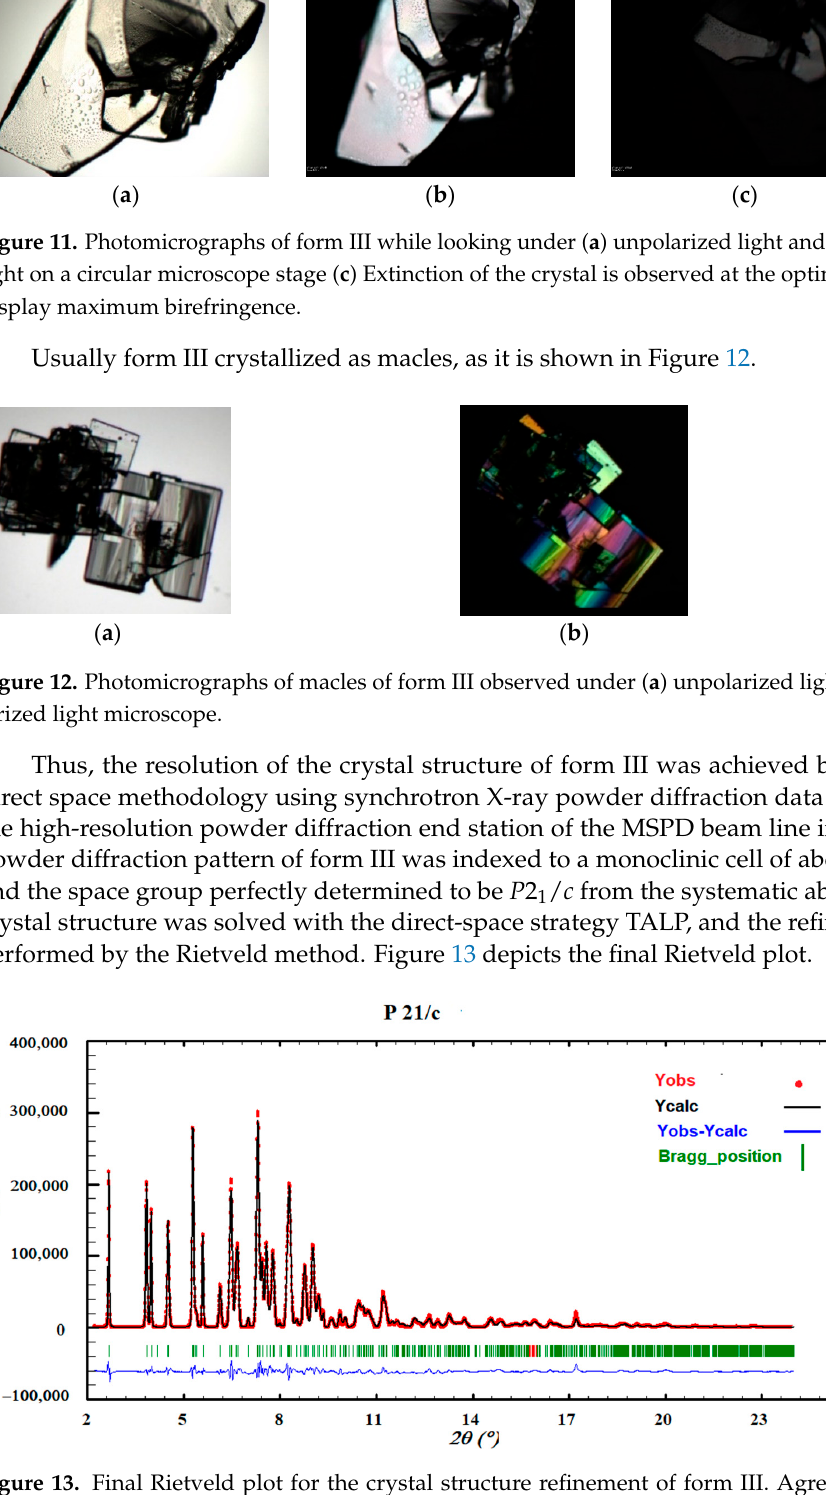
Figure 13. Final Rietveld plot for the crystal structure refinement of form III. Agreement factor: Rwp = 2.4%. The plot shows the experimental powder XRD profile (red+marks), the calculated powder XRD profile (black solid line), and the difference profile (blue, lower line). Tick marks indicate peak positions.